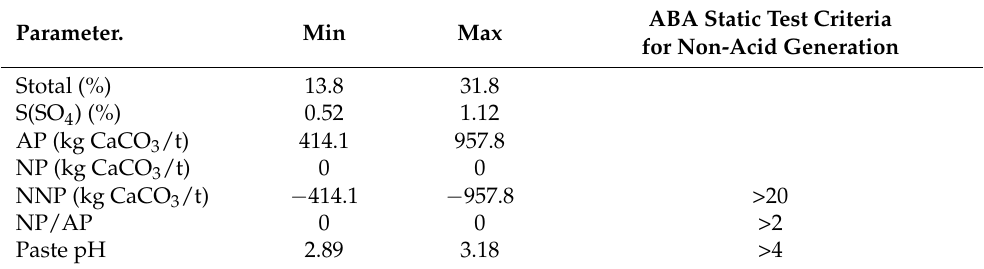
Table 3. Leachability of metals in the soil samples from the old arsenopyrites concentrate storage area (former METBA plot) before remediation